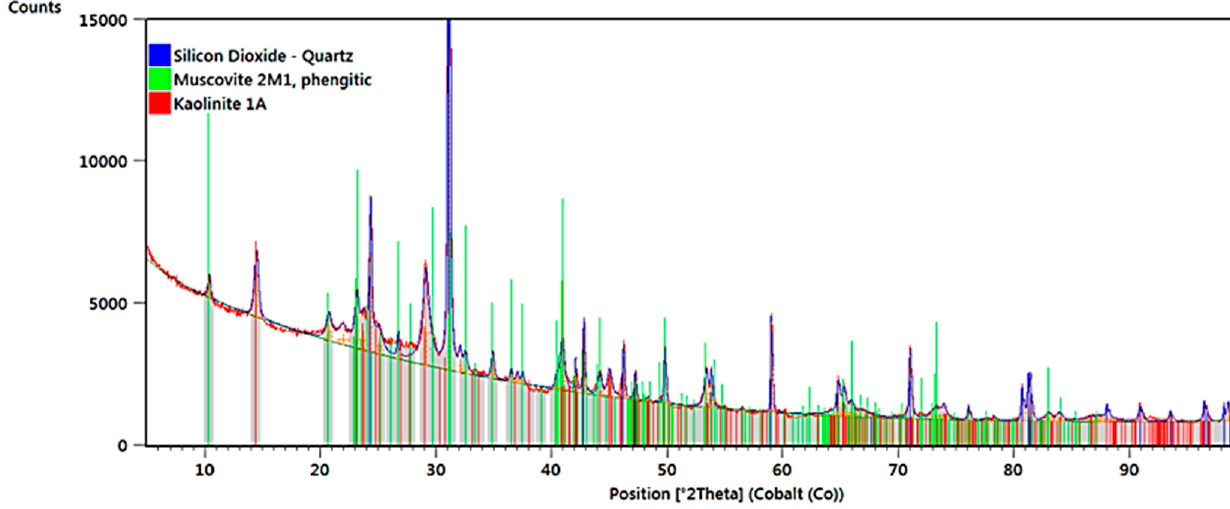
Figure 3. Diffractogram of the L group of claystone. Table 1. Results of the claystone X-ray diffraction. Pos. (°2Th.)